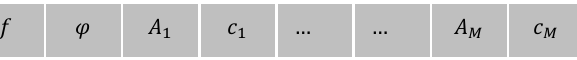
Figure 4. The unknowns for a sinusoidal fitting